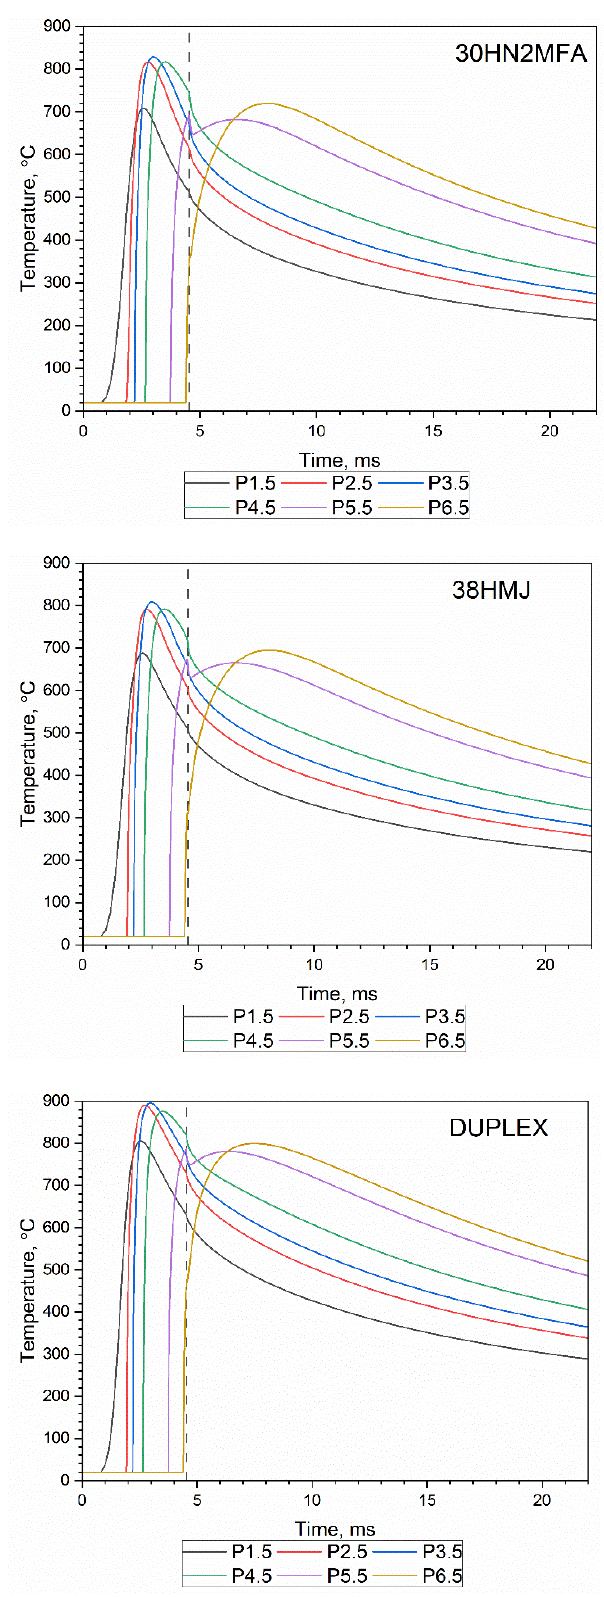
distribution 𝑇 (cid:3036) (cid:4666)𝑡, 𝑟 (cid:3036)(cid:3041) , 𝑧(cid:4667) of the inner surface of the barrel in the six zones S1 to S6 ( z in the middle of each zone) were practically the same for one shot. For each selected steel, zone S3 had the highest temperature (Figure 8). The disturbance of the temperature distribution (cid:4666)𝑡, 𝑟 𝑇 , 𝑧(cid:4667) of the inner surface barrel in zone S5 was caused by a rapid decrease in the heat (cid:3036) (cid:3036)(cid:3041) transfer coefficient ℎ (cid:3036) (cid:4666)𝑡(cid:4667) at the moment the bullet left the barrel—Figure 1. In zone S6, this effect did not occur because the bullet travelled there too briefly.